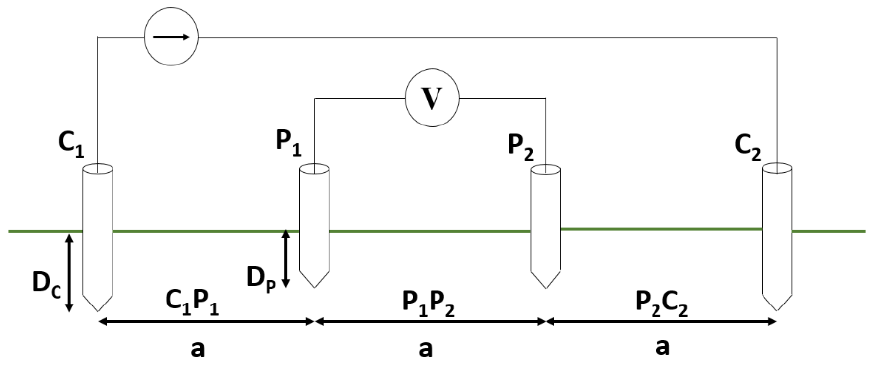
Figure 3. Wenner measurement method. Design B was a combination of a radial and a ring, which was extended from the default of Design A. The base of the tower was also 15 m × 15 m, with 10 m stranded copper cable, extended horizontally from the tower leg, and 13 vertically driven electrodes. Similarly to Design A, the burial depth of the horizontal electrode was 0.5 m from the surface, and it was made of stranded copper with a radius of 6.35 mm (or 0.00635 m), as shown in Figure